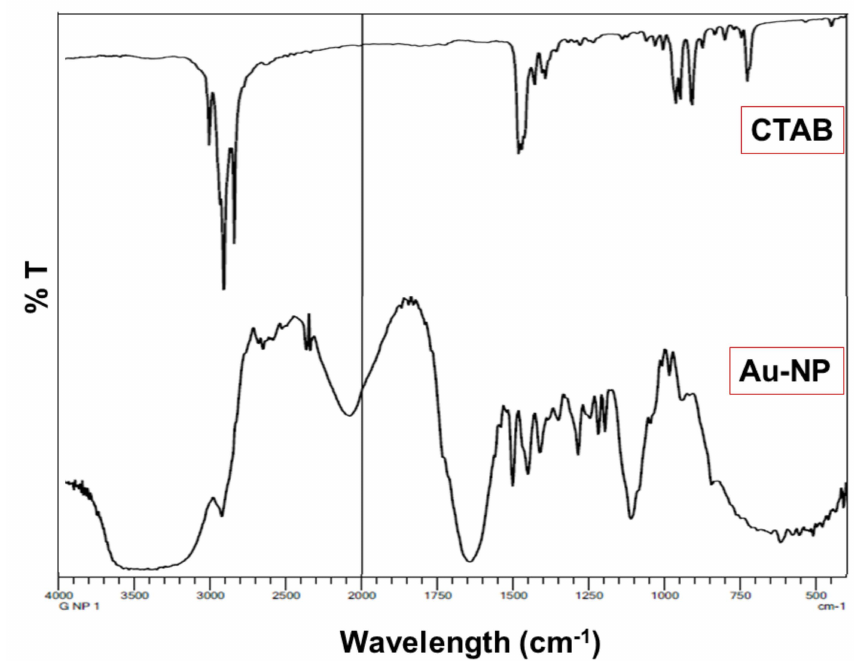
Figure 4. FTIR spectrum of the developed Au-NPs.